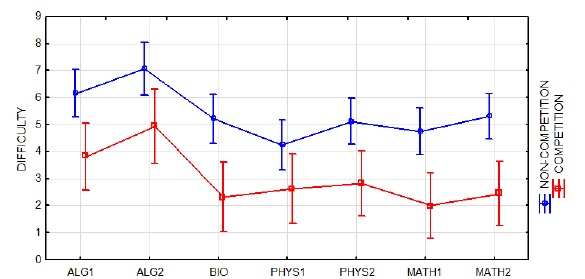
Figure 1. An evaluation of the task difficulty level – differences between the groups: Competition and Non-Competition students.